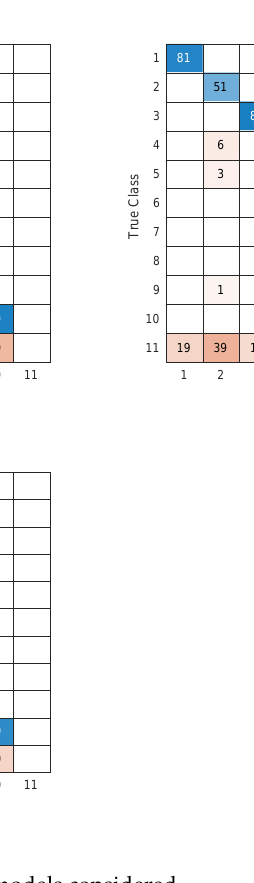
Figure 8. Confusion matrix of the three models considered. There are two other important metrics that can be evaluated: precision and recall. Precision refers to the percentage of results that are relevant; recall refers to the percentage of total relevant results correctly classified by an algorithm. For example, Figure 9 shows the precision vs. recall curve for St. Maria Valverde Church. This further demonstrates the good performance of model